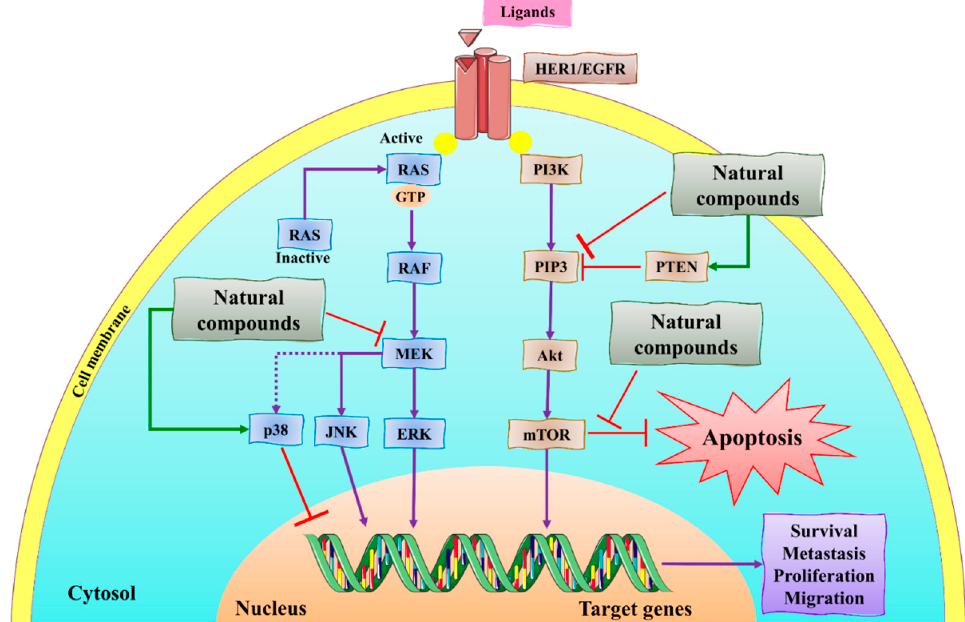
Figure 5. The schematic representation of the mechanism of action of natural compounds on MAPK/ERK and PI3K/Akt/mTOR signaling pathways can inhibit migration, survival, cell proliferation, and metastasis. PTEN: phosphatase and tensin homolog; MEK: mitogen-activated protein kinase; JNK: c-Jun N-terminal kinase; Akt: protein kinase B; ERK: extracellular signal-regulated kinase; mTOR: mammalian target of rapamycin; PIP-3: phosphatidylinositol (3,4,5)-trisphosphate. This figure is reproduced from Ganesan et al. [76] after gaining permission from Elsevier (License No. 5310141484610).